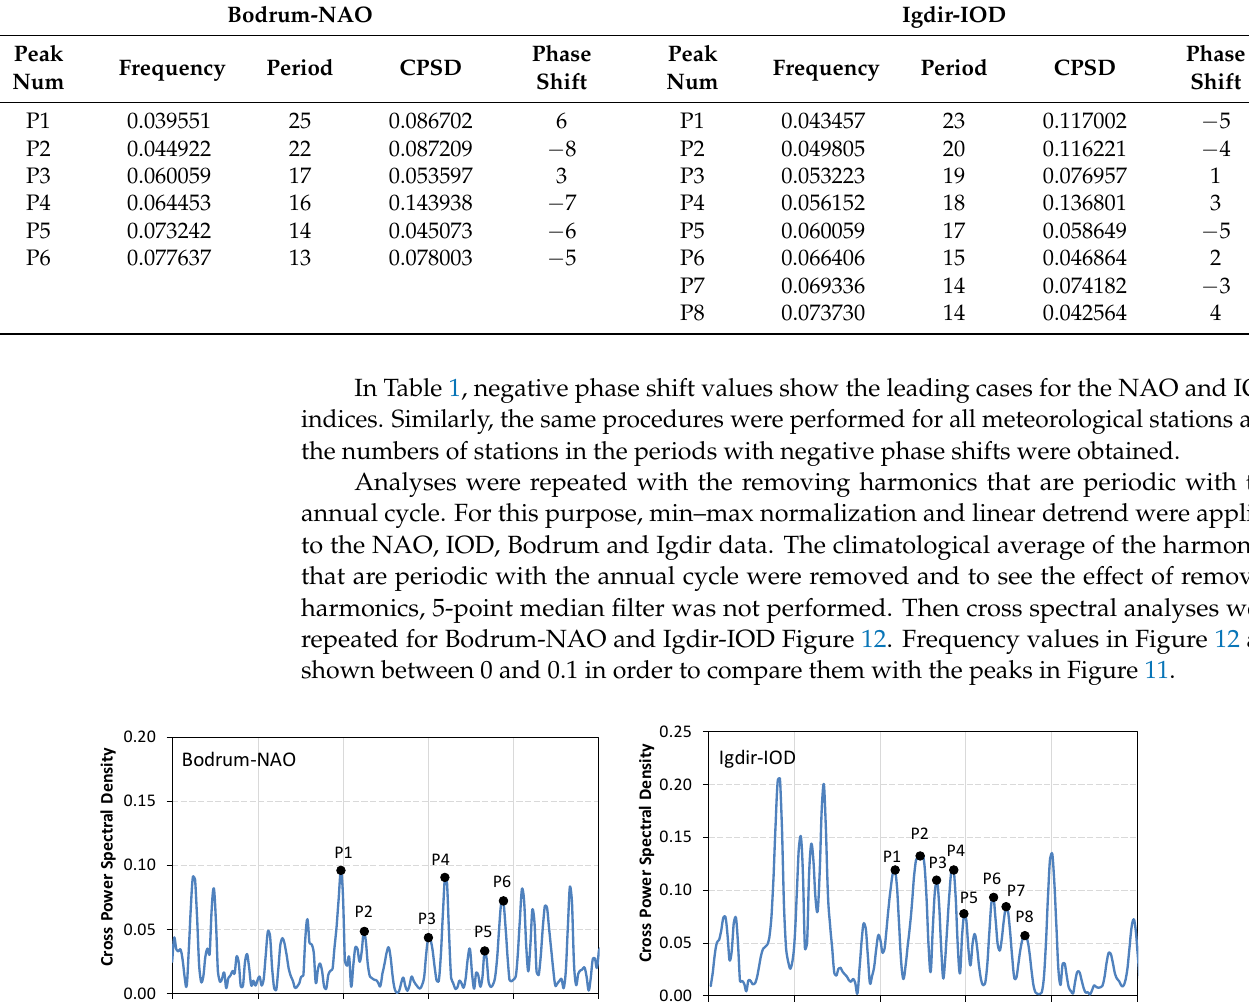
were not taken into account, which are below the red noise line. The frequencies, periods (months), CPSD values, and phase shift (Months) of the peaks are given in Table 1. Table 1. Frequency, period, cross-power spectral density (CPSD), and phase shift values of the peaks from Figure 11. Bodrum-NAO Peak Bodrum-NAO Igdir-IOD Num Phase Peak Peak Frequency Period Num